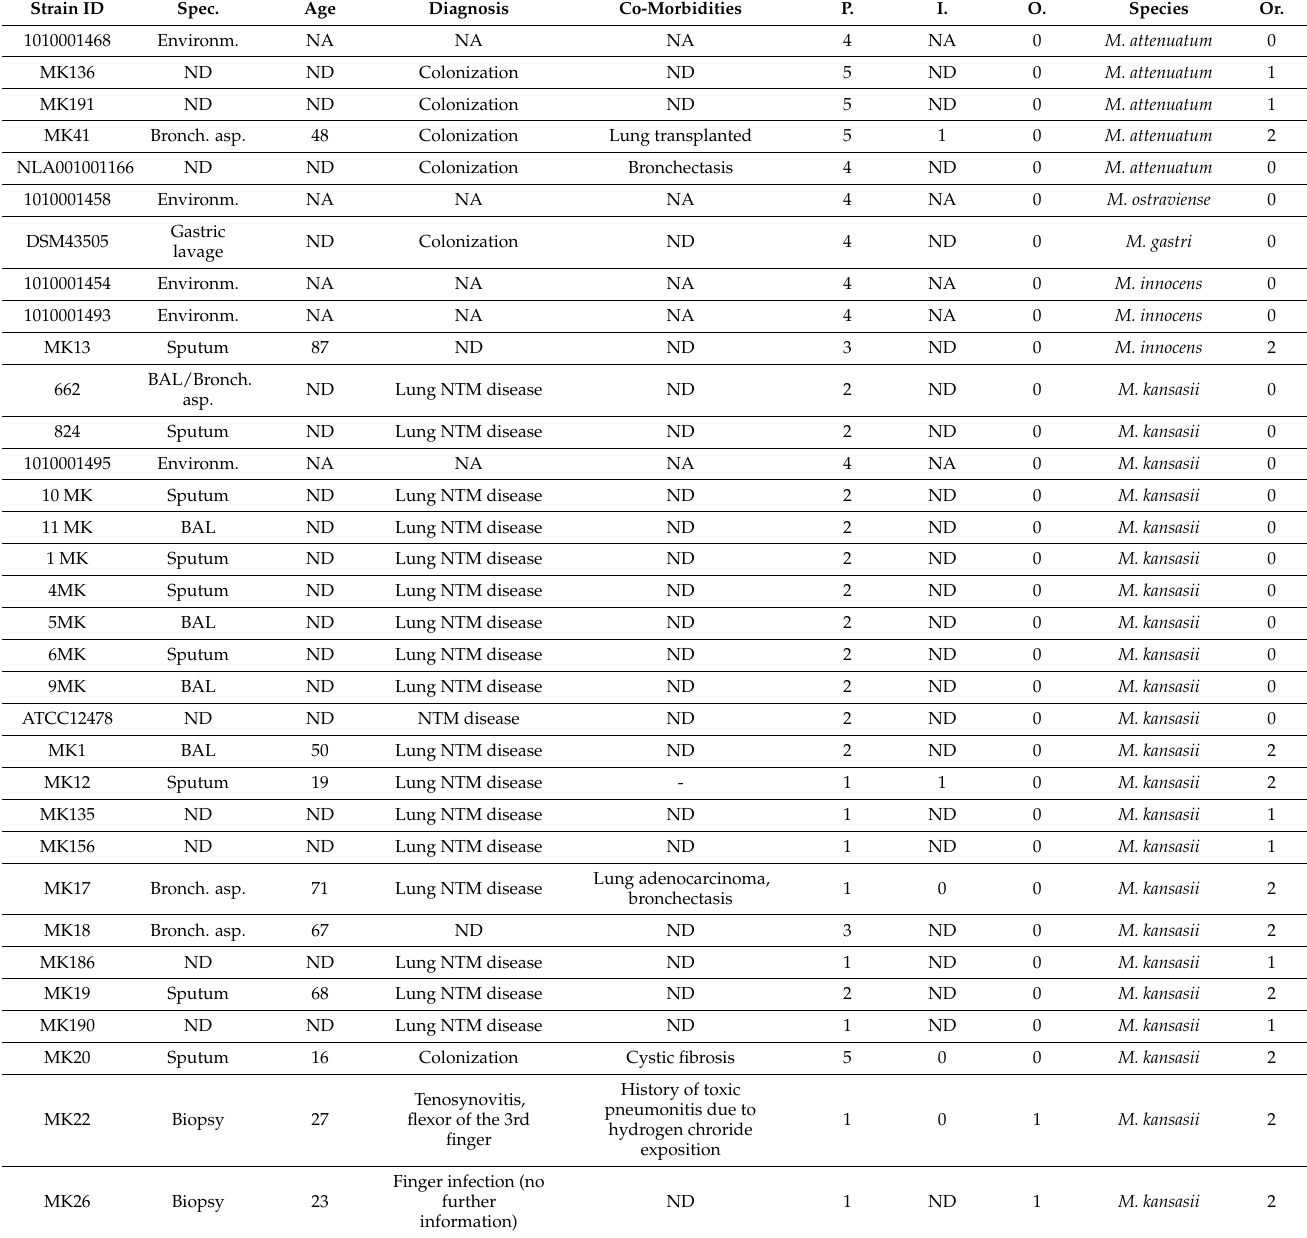
Table 1. Included strains of the M. kansasii complex and